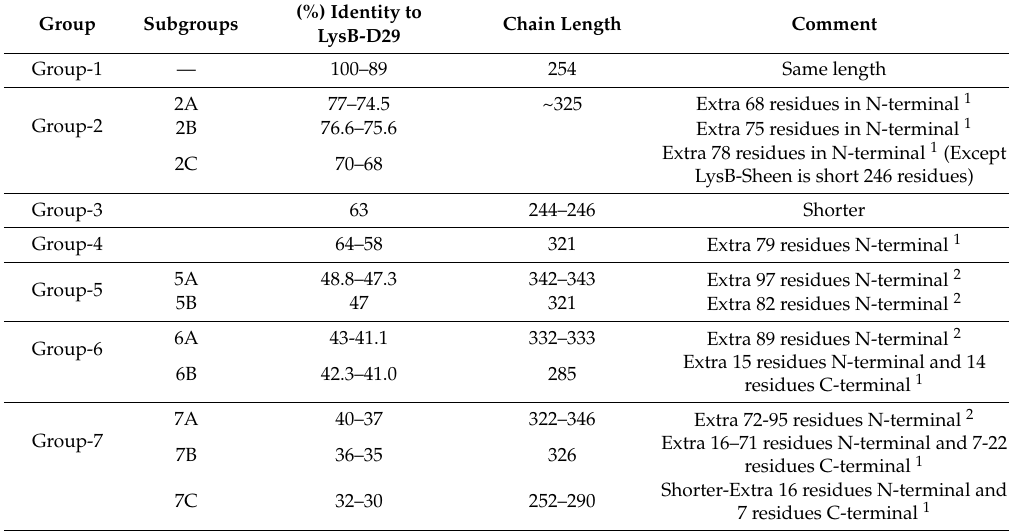
Table 2. Classification of LysB homologs according to their percentage identity to LysB-D29 and chain lengths.